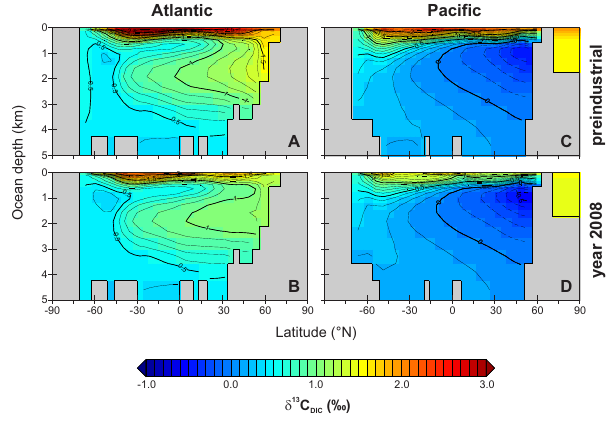
Fig. 10. Ensemble-averaged δ 13 C DIC transects through the Atlantic (25 ◦ W) and Pacific (155 ◦ W) from the pre-industrial spun-up states (upper panels) and at the end of the 1858 to 2008AD transient sim- ulations (lower